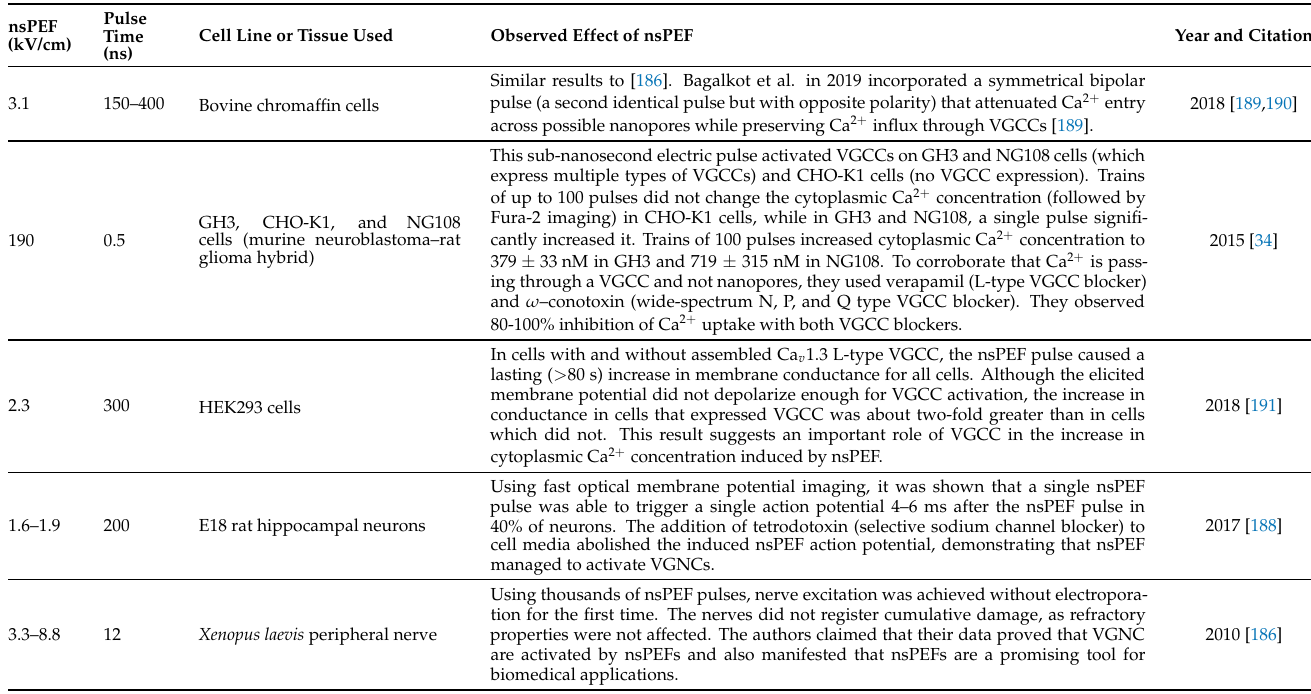
Table 2. Examples of studies demonstrating effects of nsPEF on